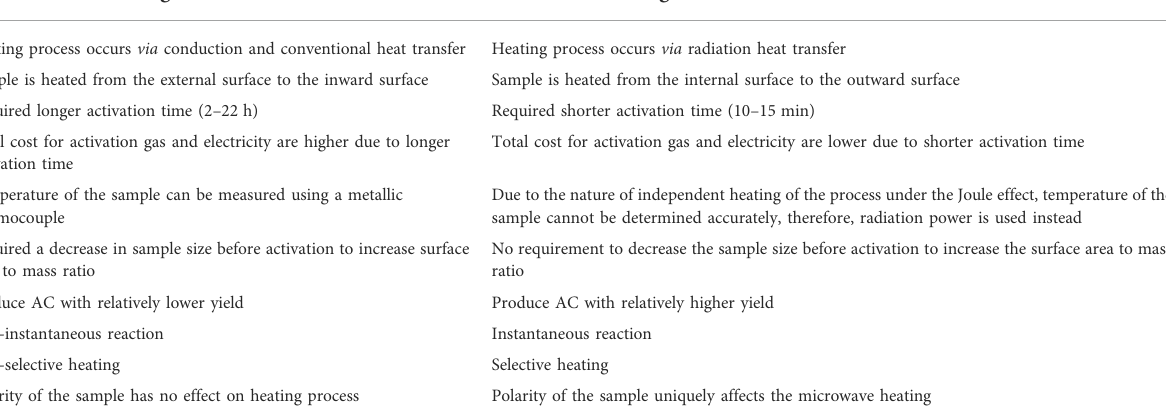
TABLE 3 Differences between CH and MH (Li et al., 2018; Liang et al., 2019; Haeldermans et al., 2020; Sasi Kumar et al., 2020; Mohamed et al., 2021; Mari Selvam and Paramasivan,